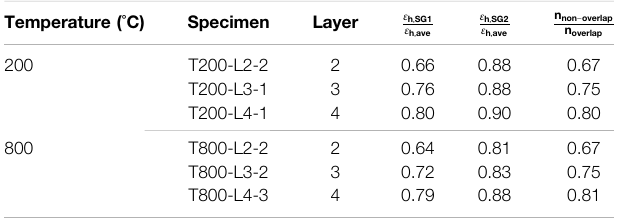
TABLE 4 | Comparisons between the strain measurements recorded in overlapping zone. Temperature ( ° C)